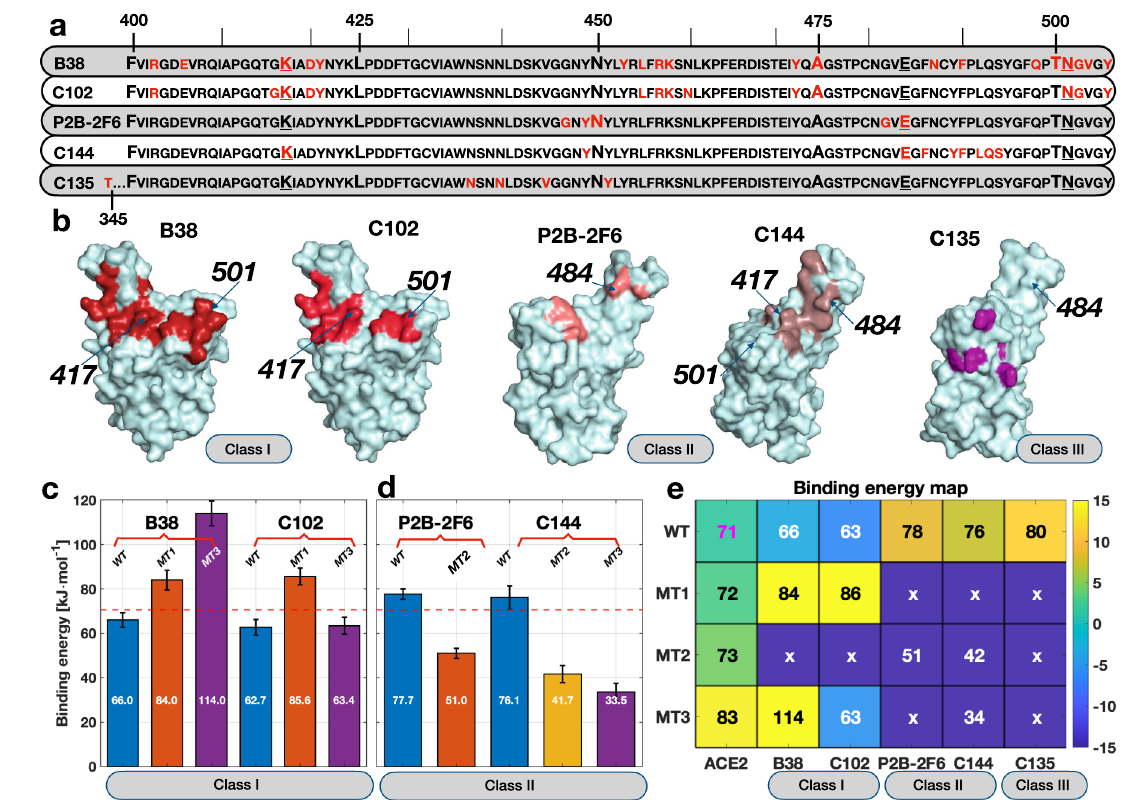
Figure 2. (a) RBD one letter sequence with contacting residues shown in red for the different hNAbs studied in this work. Amino acid residues in the WT sequence that were mutated are shown with an underline and larger font size. (b) Location of the amino acid residues in the RBD that interact with the different hNAbs. The location of the simulated mutations is also shown in the RBD geometry shown as a surface. (c) Binding energy values between the RBD (WT and mutated) and Class I hNAbs. These mutations include MT1: N501Y, MT2: E484K/N501Y, and MT3: K417N/E484K/N501Y. The values inside the bars are the compute binding energy. (d) Binding energy between the RBD (WT and mutated) and Class II hNAbs. (e) Binding energy map between RBD, ACE2, and several hNAbs. The color map indicates the difference in binding taking as a reference the WT RBD and the ACE2 receptor. The number in each cell is the actual binding energy in kJ mol indicates that the binding energy was not computed for that combination since the mutation did not affect the binding